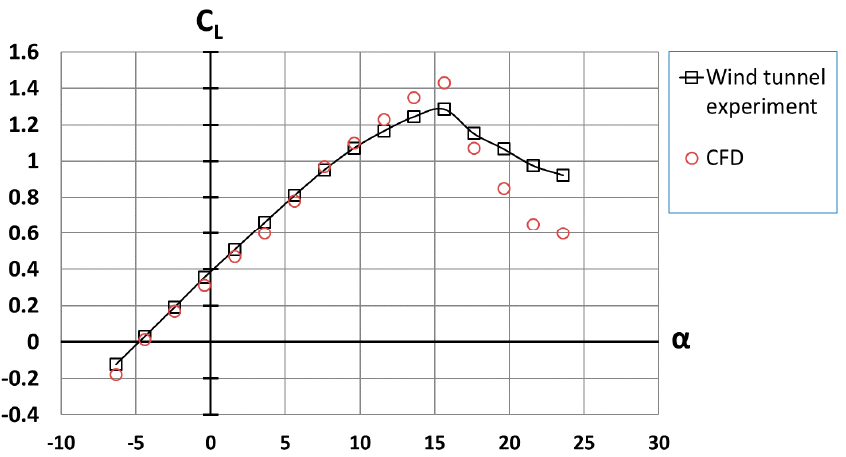
Figure 5. Computed lift coefficient values versus those obtained in wind tunnel experiment.